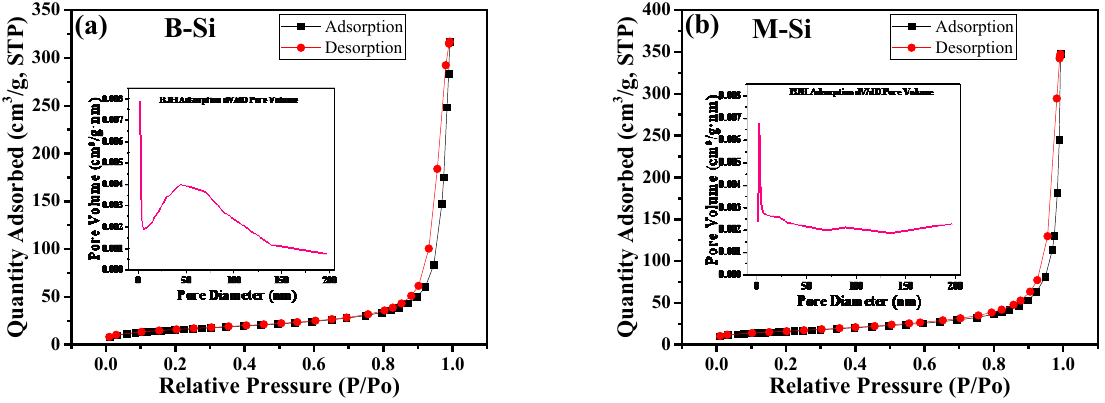
Figure 4. N 2 adsorption/desorption isotherms of ( a ) B-Si and ( b ) M-Si. Insets: the corresponding pore size distributions of B-Si and M-Si, respectively.